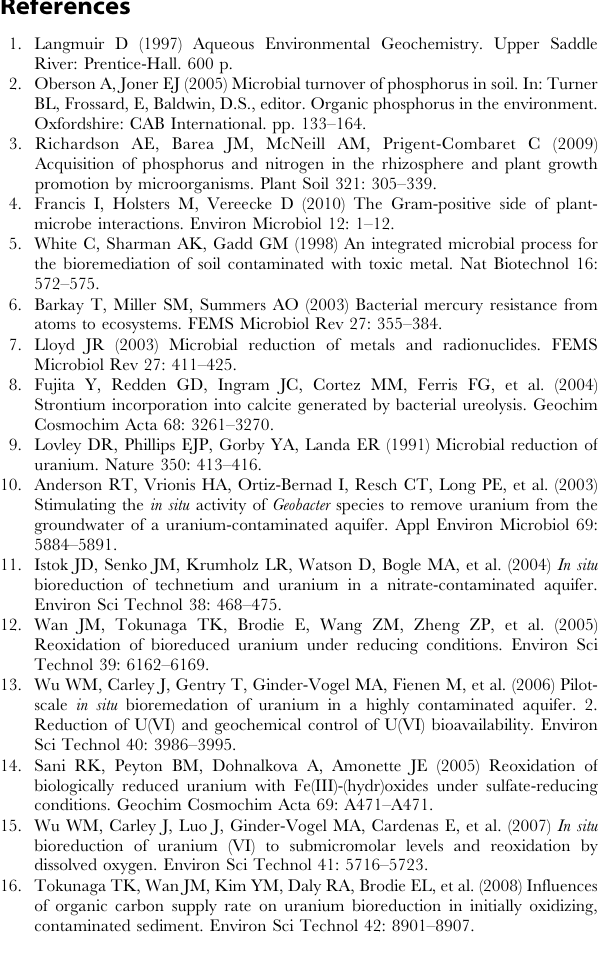
PO 43 2 = 5 mM as well as the distribution of Ca 2 + species with (C) PO 43 2 = 500 m M and (D) PO 43 2 = 5 mM. Dashed lines represent soluble species and solid lines represent insoluble species. Table S1 Total archaeal and bacterial OTUs detected in ORFRC sediments prior to treatment and following each of the six treatment conditions. Positive fraction and normalized fluorescence values are reported for each of the triplicate treatments. Table S2 OTUs with a 2-fold or greater relative increase in fluorescence intensity following sediment slurry treatments. Table S3 OTUs with a 2-fold or greater relative increase in fluorescence intensity detected in two or more